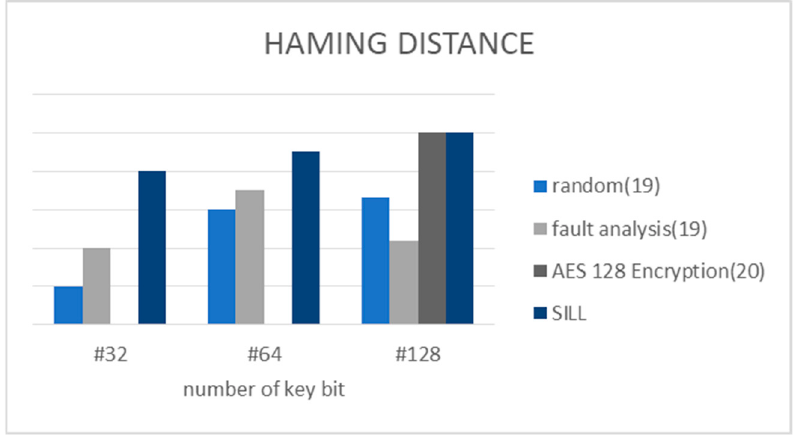
Figure 12. Comparing the Hamming distance of the proposed method (SILL) with other methods.